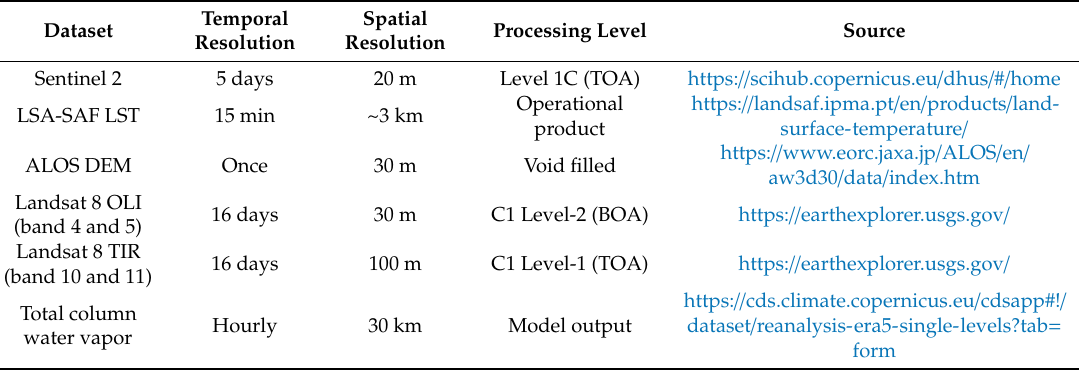
Table 1. Datasets used in this study, their source and their